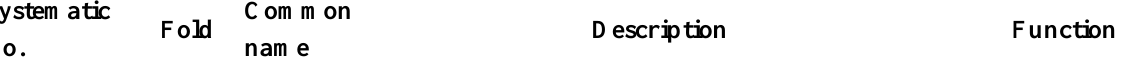
Table 2. Genes that relate to stress and detoxification among genes related to C-compound and carbohydrate metabolism, glycolysis and glyconeogenesis induced by >2-fold by T-2